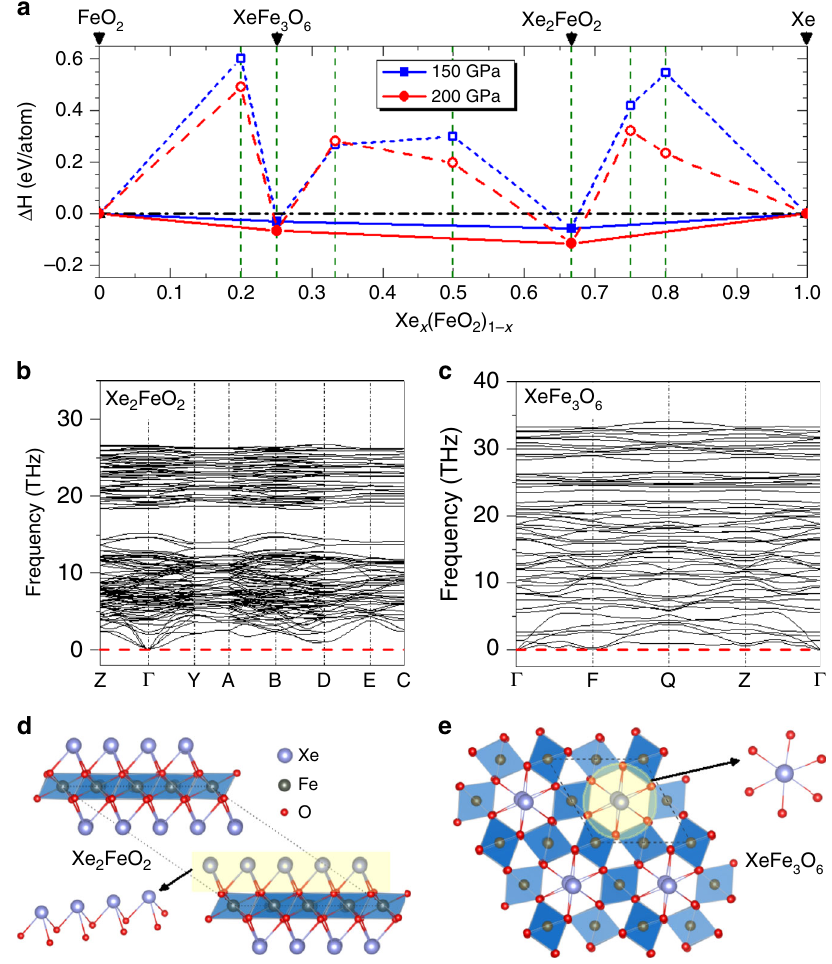
Fig. 1 Energetic stability and structures of Xe-Fe oxides. a The ground-state convex hull with solid lines for the FeO 2 -Xe system constructed from calculated formation enthalpy ( Δ H ) data, identifying two stable Xe-Fe oxides, Xe 2 FeO 2 and XeFe 3 O 6 , at 150 GPa and 200 GPa. The solid and open symbols represent the stable structures lying on the convex hull and the unstable structures above the convex hull, respectively. b Phonon dispersions of Xe 2 FeO 2 at 150 GPa. c Phonon dispersions of Xe 3 FeO 6 at 150 GPa. d The structure of Xe 2 FeO 2 with a polyhedral and an enlarged view. e The structure of Xe 3 FeO 6 with a polyhedral and an enlarged view. Xe, Fe, and O atoms are, respectively, shown in purple, gray, and red